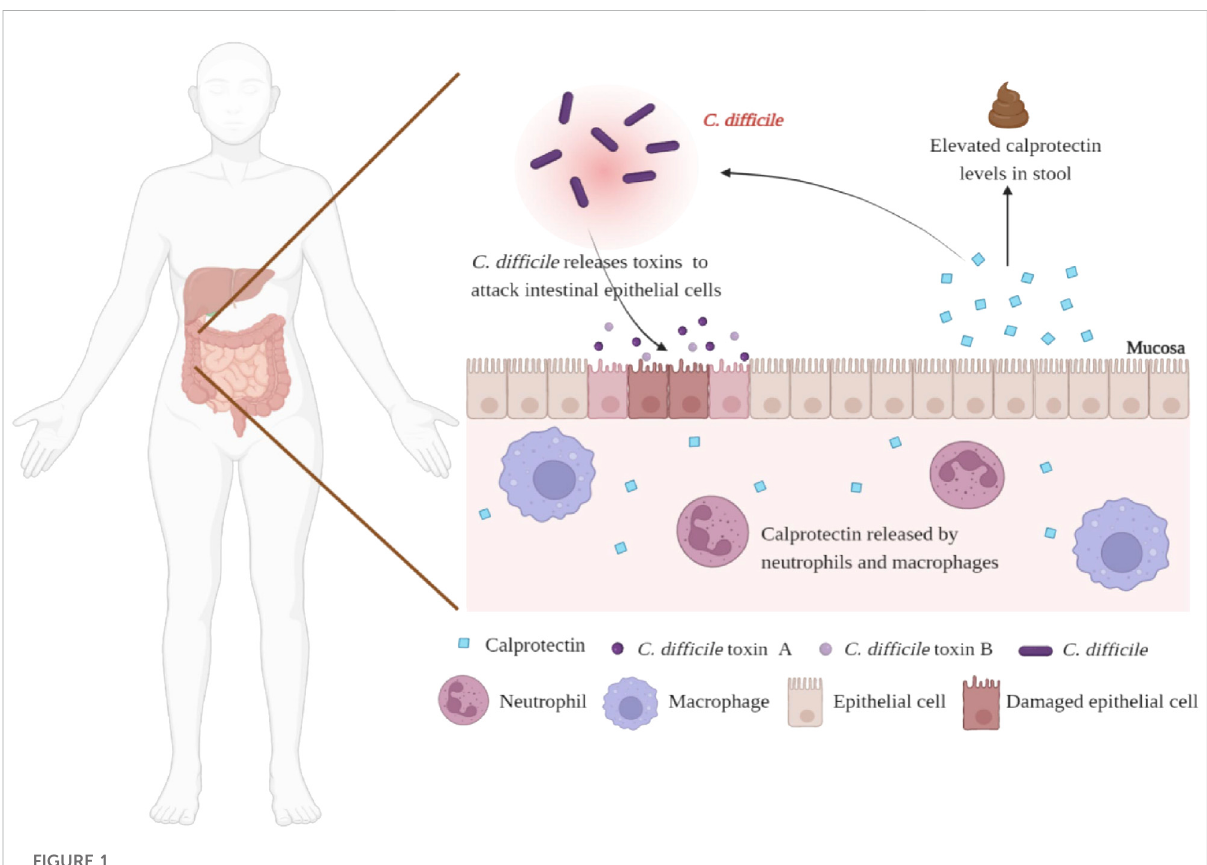
FIGURE 1 Schematic diagram of elevated fCP levels in CDI